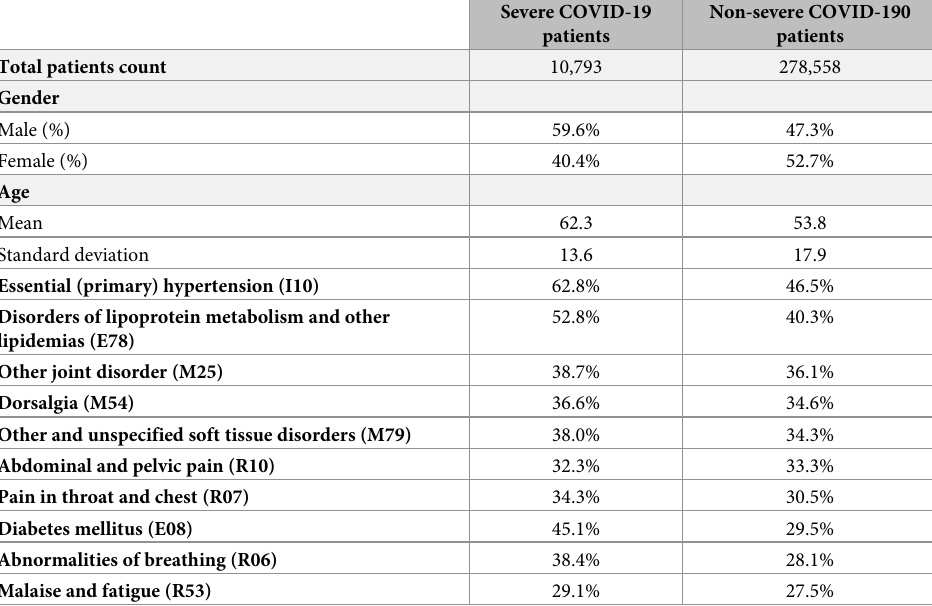
Table 1. Baseline characteristics of patients in the study cohort. Patients are defined as “Severe” if diagnosed with Acute Respiratory Distress Syndrome (ARDS) within 4 months from COVID-19 infection. The ten most prevalent comorbidities in the study cohort are shown alongside their respective ICD-10 codes.